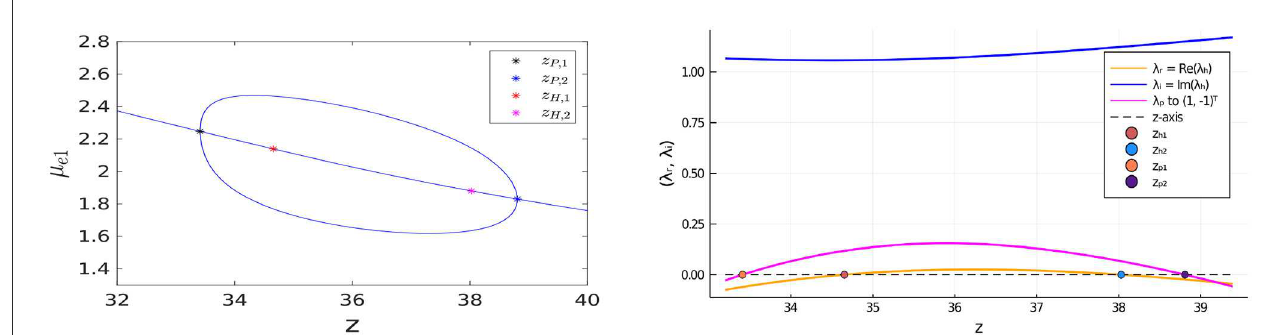
FIGURE16 Left: Bifurcation diagram of µ e 1 vs. z , computed from Equation (4.12) using MatCont [51], for symmetric and asymmetric steady-states of a two-cell ring pattern with the same parameters as in the Figure 14, Left except that now the degradation rates are decreased slightly to σ u parameter set, there are Hopf bifurcation points associated with in-phase perturbations of the symmetric steady-state that emerge at z z H ,2 and z 38.02834 between the two symmetry-breaking pitchfork bifurcation points located at z = ≈ the root λ of σ 2 ( λ ) 0 vs. z (pink curve), as computed from Equation (3.20), shows that the symmetric steady-state solution branch is unstable to = anti-phase perturbations on the range z P ,1 < z < z P ,2 . The plotted real and imaginary parts of the complex-valued root λ h Equation (3.20), shows that Re( λ h ) > 0 on the range z H ,1 < z < z H ,2 . On this range of z , a synchronous oscillatory instability of the symmetric steady-state solution can also occur, but it has a smaller growth rate than that for the anti-phase